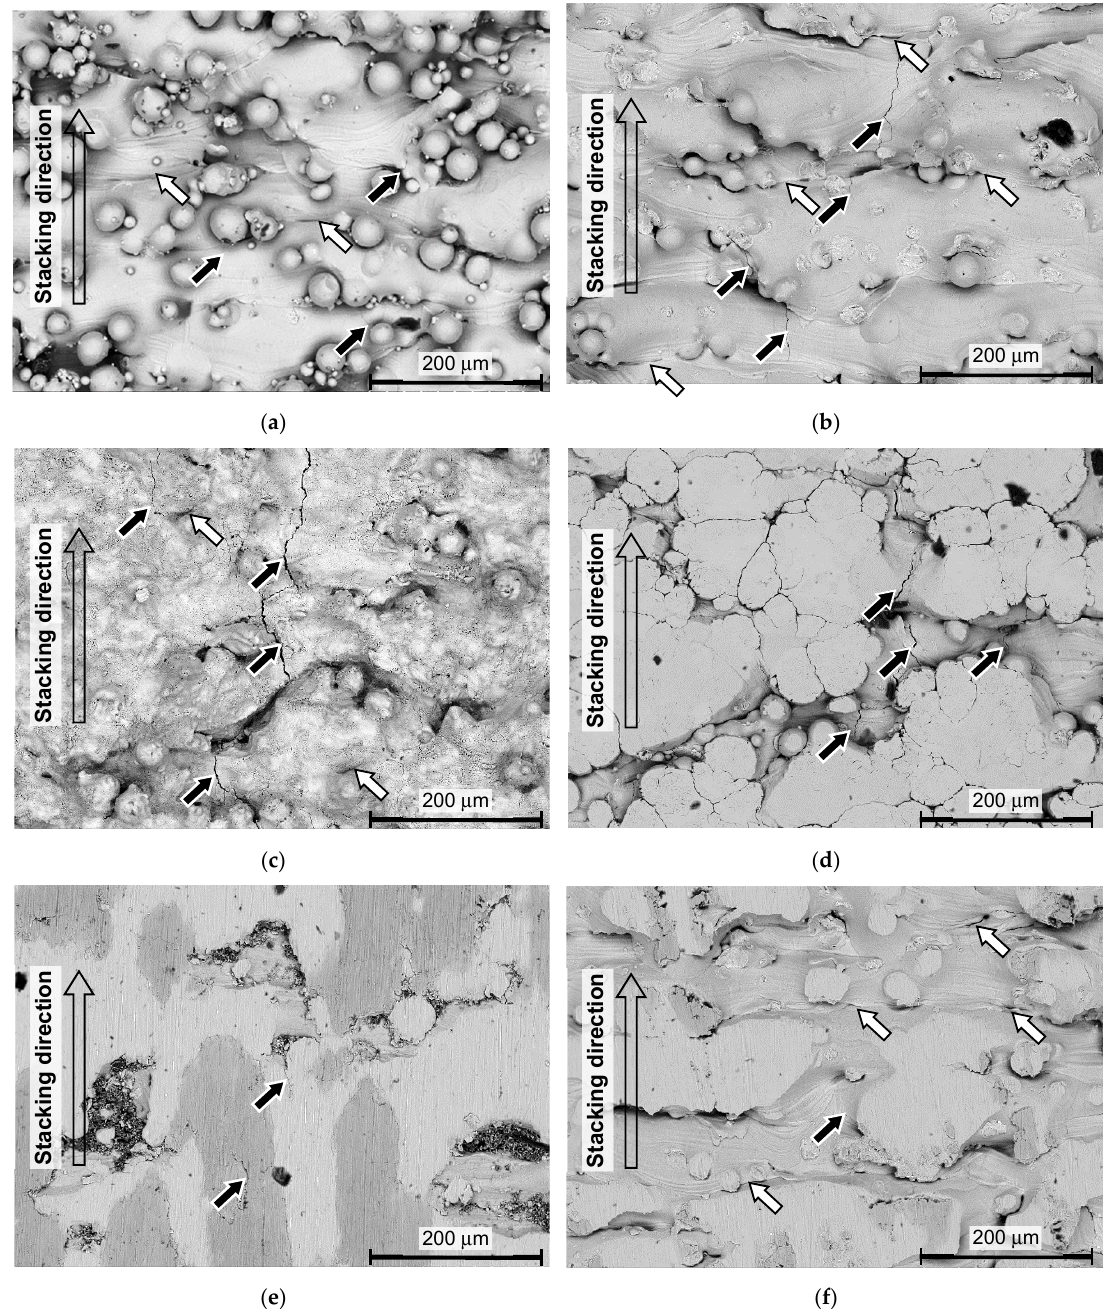
Figure 11. Aspects of the surface near the fracture of the specimen manufactured by DMLS, observed by scanning electron microscope (SEM). ( a ) As-built ( σ a = 301 MPa, N = 162,400); ( b ) cavitation peening ( σ a = 370 MPa, N = 291,600); ( c ) laser peening ( σ a = 400 MPa, N = 352,200); ( d ) shot peening ( σ a = 361 MPa, N = 764,800); ( e ) grinding ( σ a = 350 MPa, N = 141,000); ( f ) grinding and cavitation peening ( σ a = 450 MPa, N = 310,000).